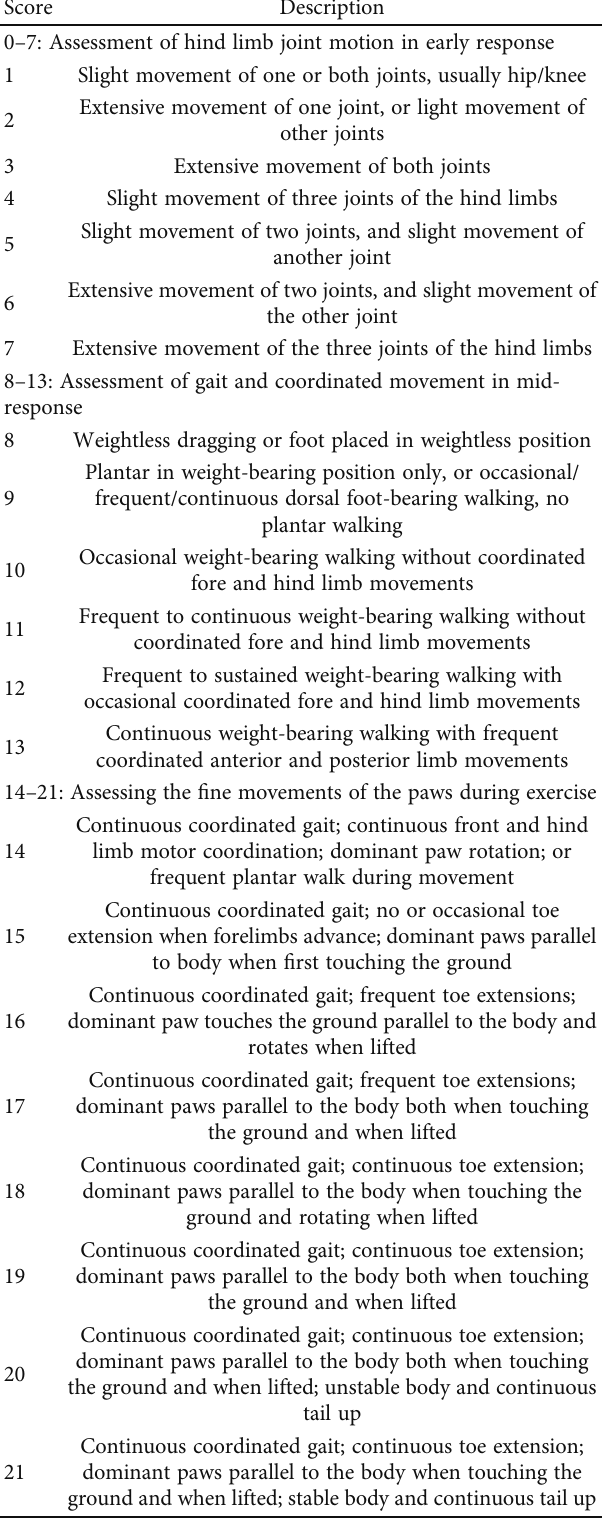
Table 1: BBB Sport Rating